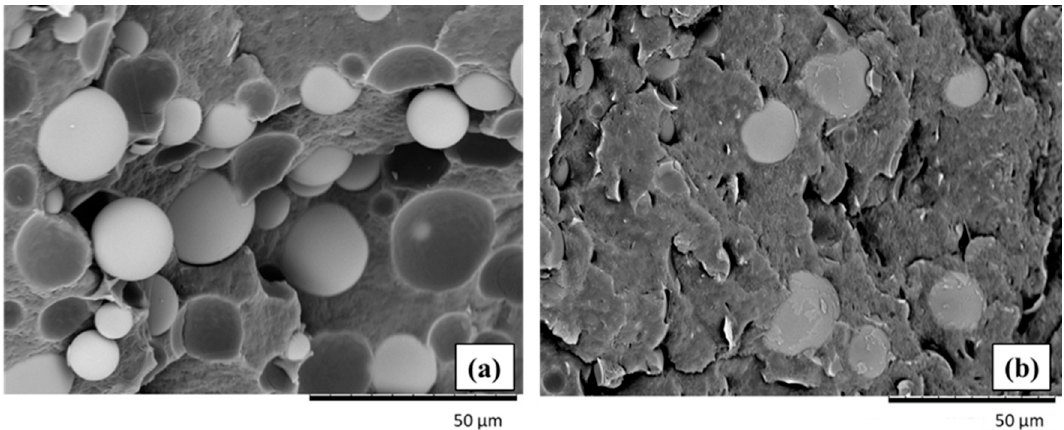
Figure 5. SEM image of PCL composites with 10% of HGM alone ( a ) and after surface modification with APTES ( b ).